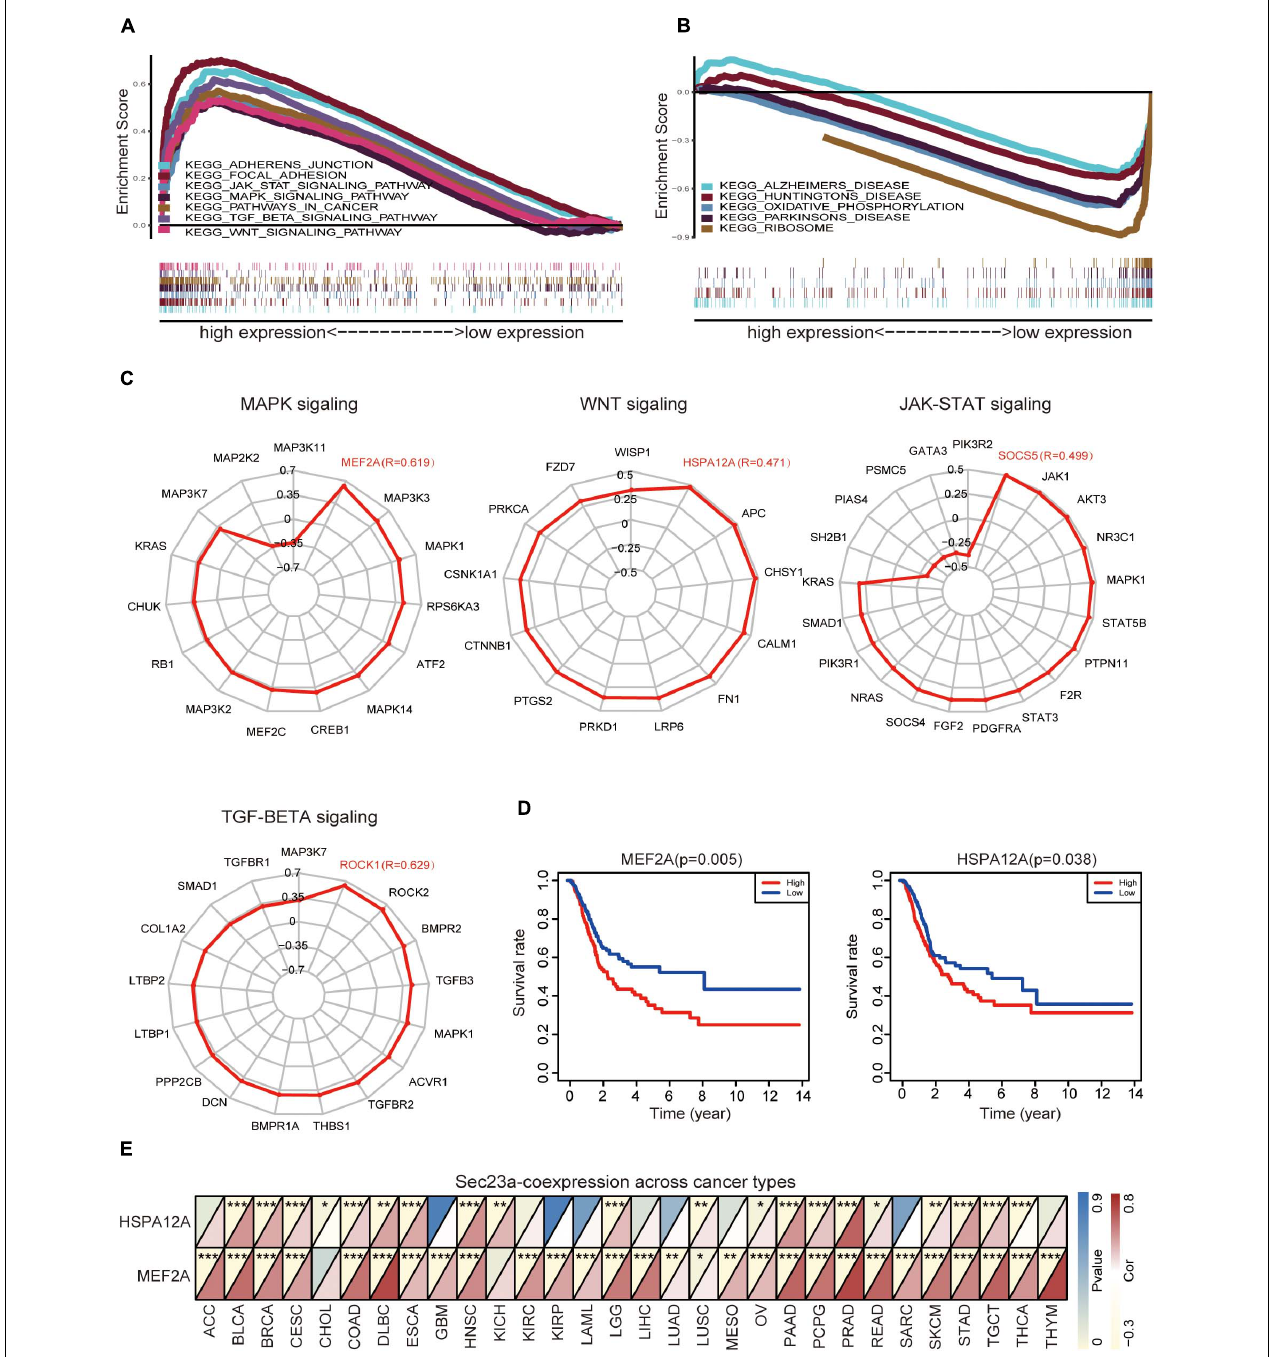
FIGURE 4 | GSEA analysis prioritized differentially enriched genes in KEGG that correlated with SEC23A expression. (A) HIGH expression in SEC23A. (B) LOW expression in SEC23A. (C) The correlation between SEC23A and Key genes of MAPK,WNT, JAK-STAT, and TGF-BETA signaling pathway ( R ≥ | 0.3|). (D) KM survival analysis of MEF2A and Hspa12a base on TCGA. (E) Pearson analysis of MEF2A and Hspa12a related to SEC23A in Pan-cancer patients. MEF2A has a higher level of correlation (* p < 0.01; ** p < 0.01; and *** p <